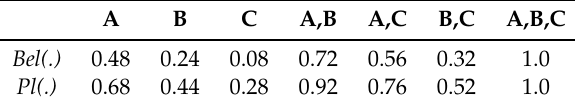
Table 1. Bel and Pl values for Example